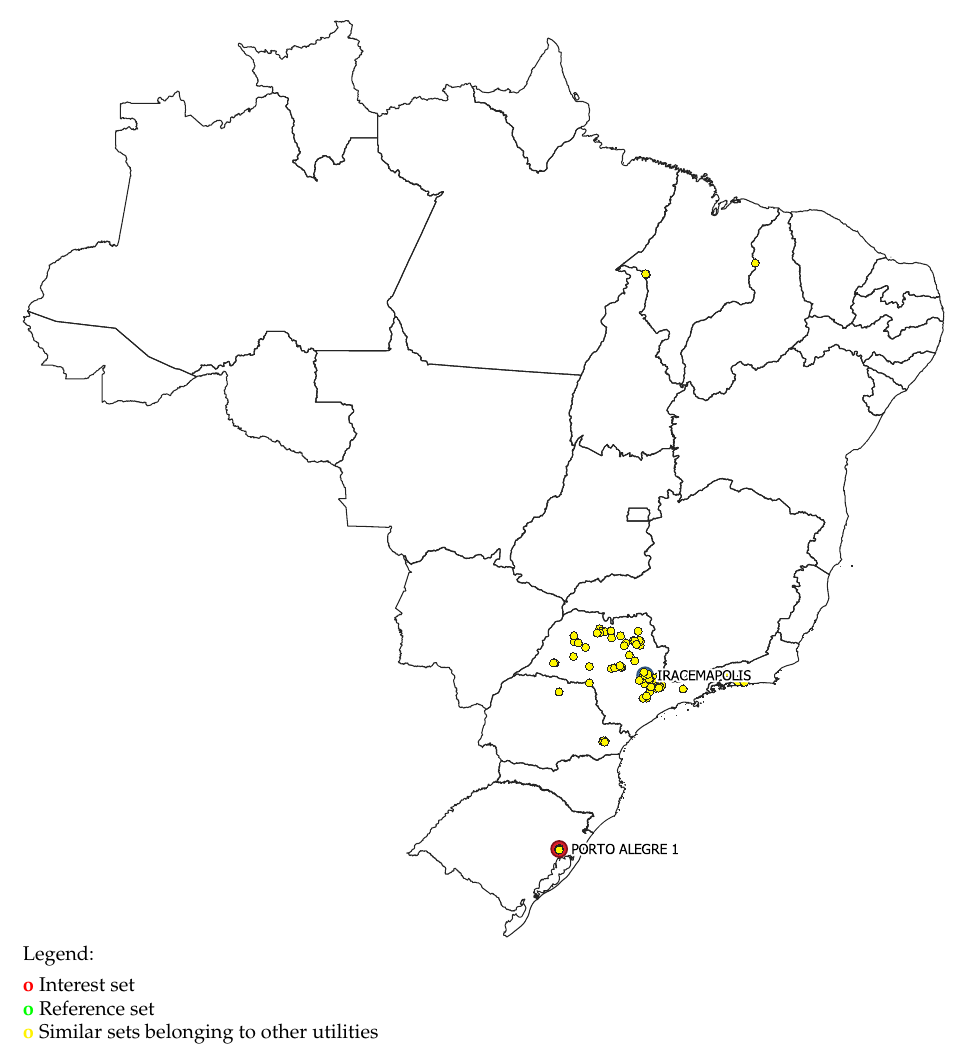
Figure 10. Geographic location of all 100 sets of cluster belonging to the Porto Alegre